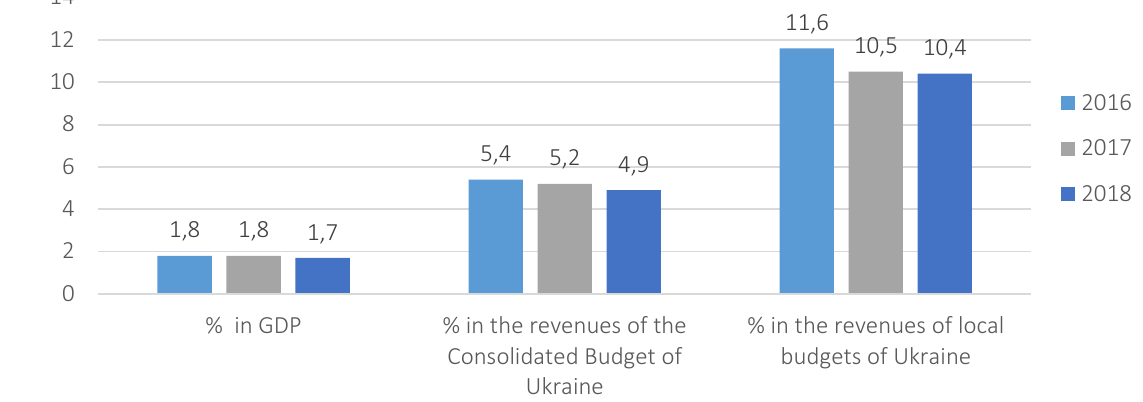
Figure 3. Changes in the share of local taxes of Ukraine in 2016–2018